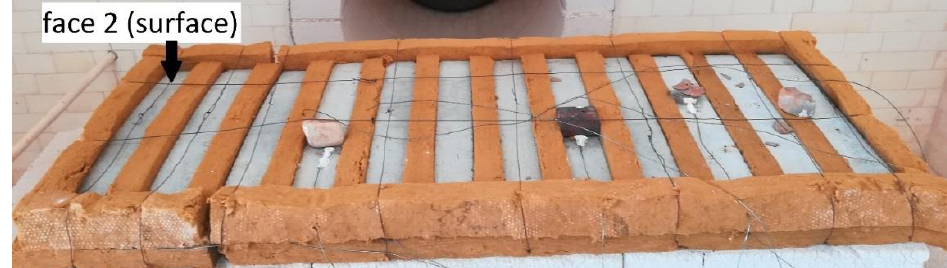
Figure 4. Set-up of specimens from Series B, C, D and F for the execution of the fire test. At the end